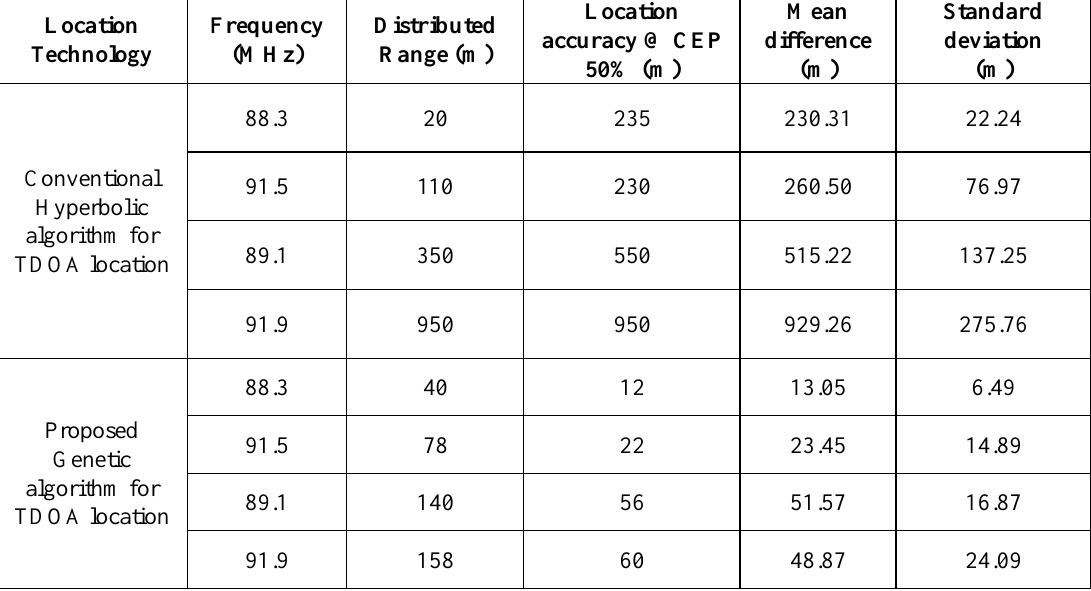
Table 4. The summarized results of the experiment for TDOA–based measured